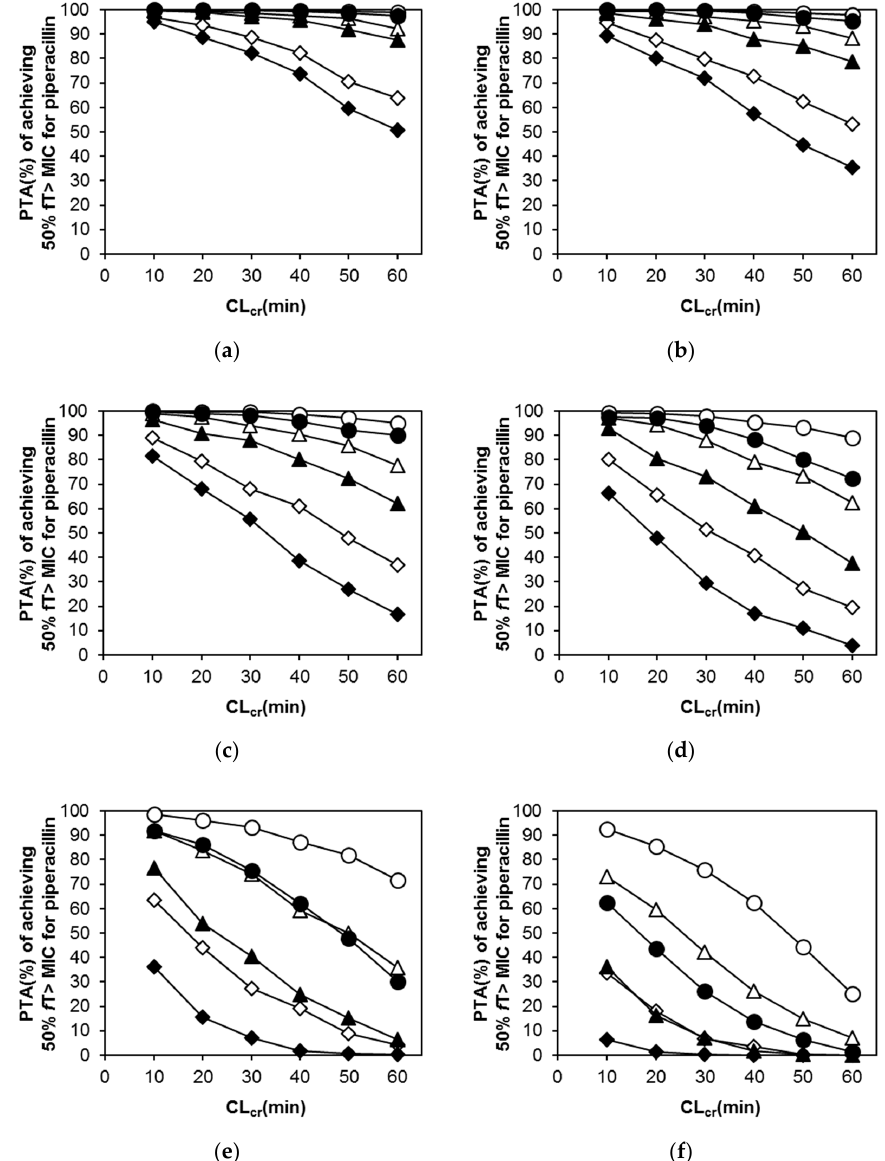
Figure 3. Probability of target attainment (PTA) of achieving 50% f T > MIC for piperacillin when administered in late elderly patients. MIC: minimum inhibitory concentration, CL cr : creatinine clearance. ( a ) MIC = 2 μ g/mL; ( b ) MIC = 4 μ g/mL; ( c ) MIC = 8 μ g/mL; ( d ) MIC = 16 μ g/mL; ( e ) MIC = 32 μ g/mL; ( f ) MIC = 64 μ g/mL. ○ : 4.5 g(PIPC4.0 g) q6h, △ : 4.5 g(PIPC4.0 g) q8h, ◇ : 4.5 g (PIPC4.0 g) q12h, ● : 2.25 g (PIPC2.0 g) q6h, ▲ : 2.25 g (PIPC2.0 g) q8h, ◆ : 2.25 g(PIPC2.0 g) q12h.